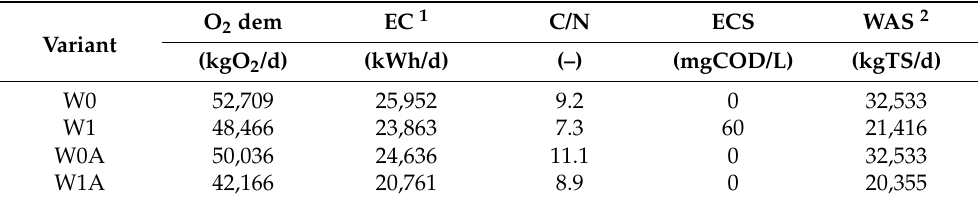
Table 5. Parameters of the biological part of a wastewater treatment plant (WWTP) for each analyzed scenario.